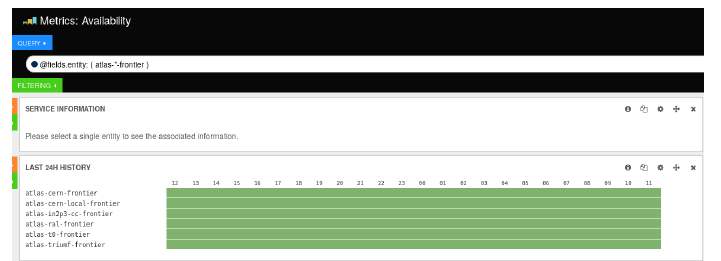
Figure 6. Kibana monitoring page of Frontier servlets